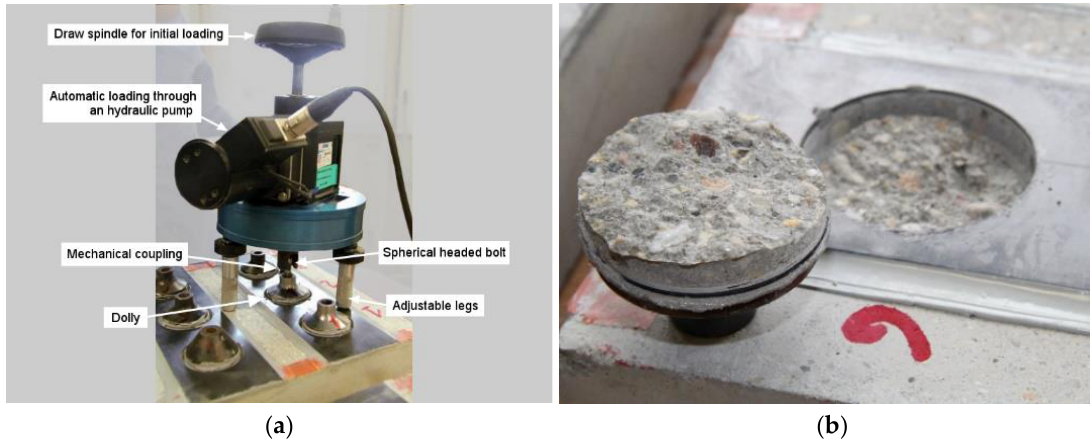
Figure 1. ( a ) Commercial pull-off tester; ( b ) typical cohesive failure in concrete substrate with pull-off strength of 5.9 MPa, demonstrating a sound bonded FRP system according to the standards.